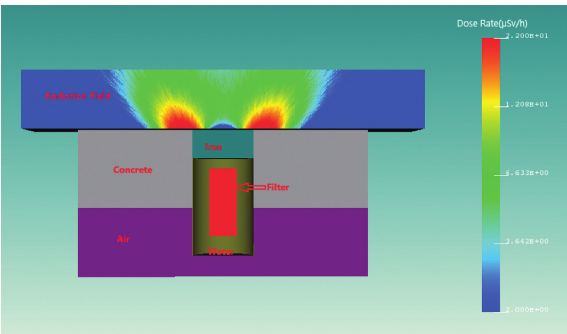
Figure 9: Shielding evaluation for the reactor coolant filter.